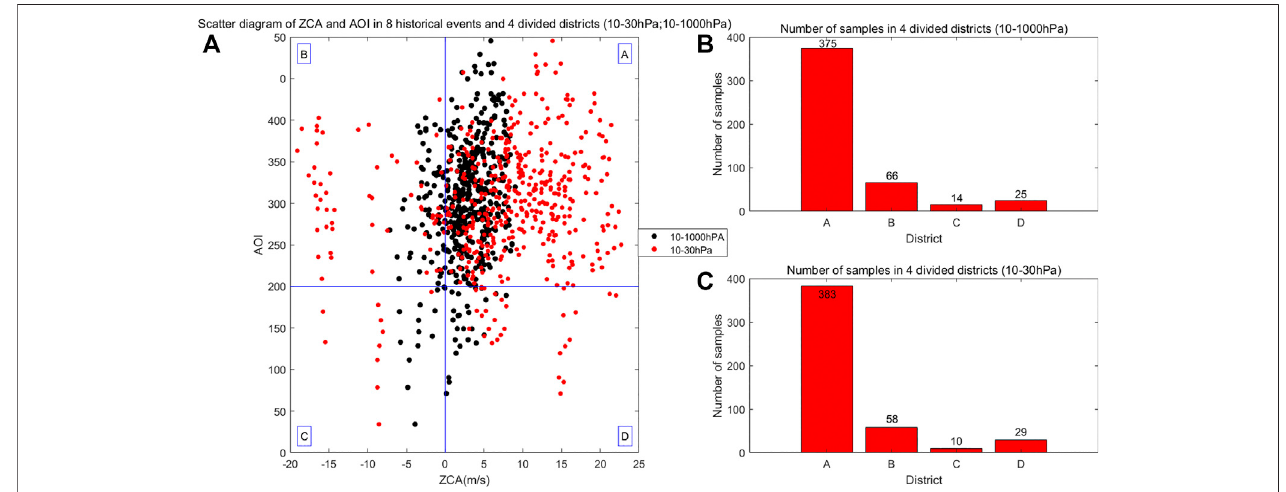
FIGURE 8 | (A) Scatter diagram of the ZCA and AOI for eight historical events and four divided districts (10 – 30 hPa; 10 – 1,000 hPa). (B) Number of samples in the four divided districts at 10 – 1,000 hPa. (C) Number of samples in the four divided districts at 10 – 30 hPa.